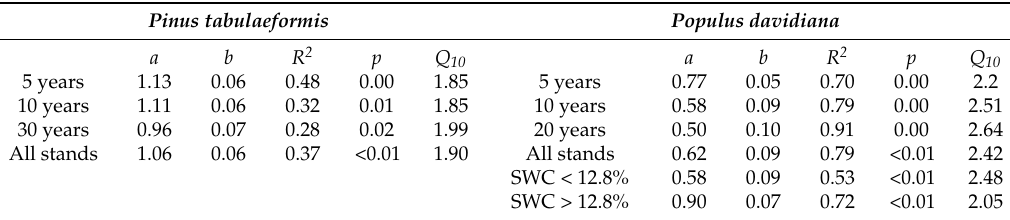
Figure 5. Relationships between soil respiration and soil temperature at a depth of 5 cm ( a ) and soil water content at 10 cm ( b ) at different stand ages in P. tabulaeformis and P. davidiana plantations during the growing season (from May to October) of 2013. PT and PD represent P. tabulaeformis and P. davidiana plantations, respectively, and the symbols represent stand ages. Each value represents the mean of nine measurements in each stand. The solid line, dashed line and dotted line indicate the exponential curves of the soil respiration rate and soil temperature at a depth of 5 cm at three stand ages (5-, 10-, and 30/20-year-old) in the P. tabulaeformis and P. davidiana plantations. Grey horizontal lines in Figure 5b indicate mean soil respiration in each forest type, and the grey vertical line indicates a threshold point for soil water content in P. davidiana . Table 3. Q 10 values, regression coefficients, and determination coefficient of relationships between soil respiration (SR) and soil temperature (ST), according to y = ae bT , in different aged Pinus tabulaeformis and Populus davidiana plantations and at a soil water content (SWC) below or above 12.8% in P. davidiana plantations.